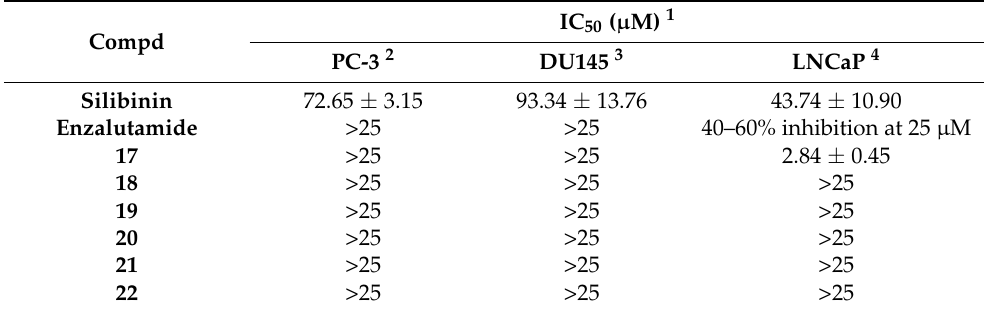
Table 2. Antiproliferative activity of 5,7,20- O -trimethylhydnocarpins 17 – 22